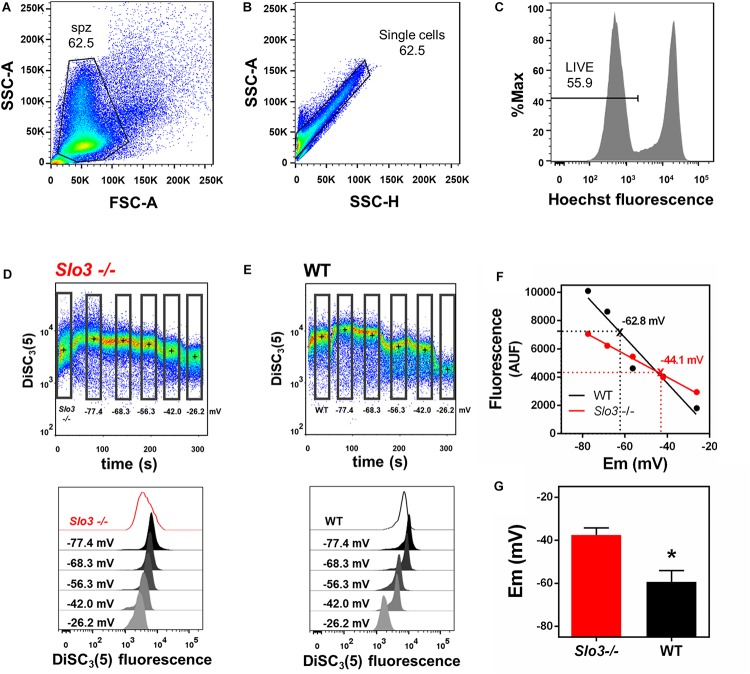
Flow cytometry can be used to determine absolute values of membrane potential in wild type and Slo3–/– mouse sperm. (A) Forward-scatter (FSC) and side-scatter (SSC) light data were collected. Threshold levels for side-scatter area (SSC-A) and forward-scatter area (FSC-A) were set to exclude signals from cellular debris or cells with abnormal morphology. (B) Threshold levels of two-dimensional dot plot of SSC-A vs. side-scatter height (SSC-H) were set to include only single cells and exclude clumps. (C) Cells with bright Hoechst staining were excluded to measure DiSC3(5) fluorescence only in live sperm. (D,E) Upper panel: Representative dot plot of DiSC3(5) fluorescence from Slo3–/– (D) and WT (E) mouse sperm incubated in capacitated conditions. Calibration was performed by adding 1 μM valinomycin and sequentially adding KCl, corresponding to the theoretical plasma membrane potential values of –77.4, –68.3, –56.3, –42.0, and –26.2 mV ([K+]i of 120 mM). Black crosses indicate the median DiSC3(5) fluorescence of sperm within the gates (rectangles) defined for each addition. Lower panels: Histograms of DiSC3(5) fluorescence from selected gates as indicated in flow cytometry dot plots. (F) Linear regression of the calibration curves constructed from the median DiSC3(5) fluorescence from Slo3–/– and WT sperm obtained in D and E. Interpolated values for each curve are indicated with X and dotted lines. Slo3–/–
r2 = 0.9948; WT r2 = 0.9311. (G) Membrane potential of Slo3–/– and WT capacitated sperm. ∗P = 0.0265 by unpaired t-test.